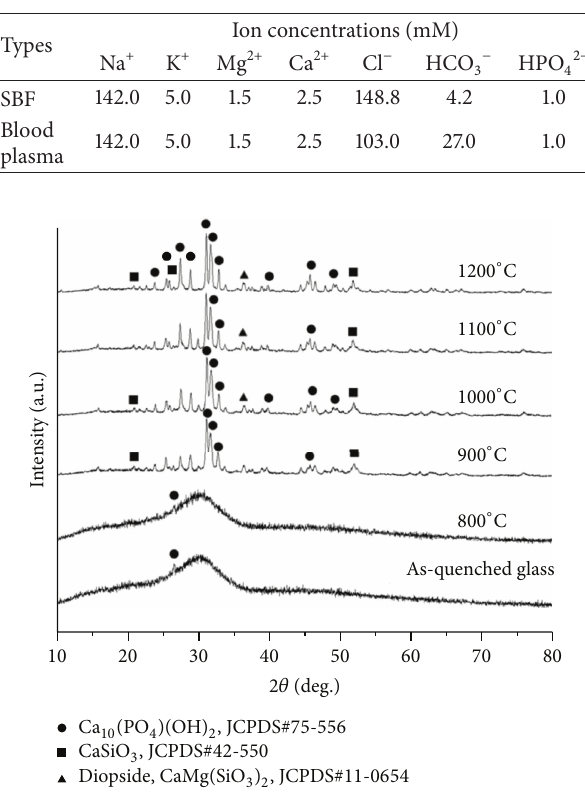
Figure 1: XRD patterns of AW based glass and the heat-treated samples of AW based glass at 800, 900, 1000, 1100, and 1200 ∘ C for 2 h.